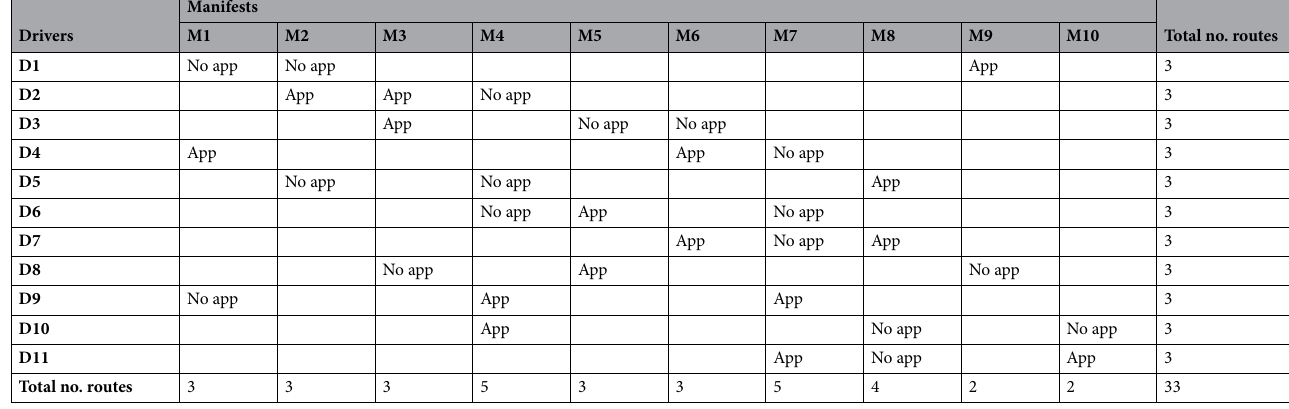
Table 1. Experimental design. No app, route was performed without access to OpenPark app; App, route was performed with access to OpenPark